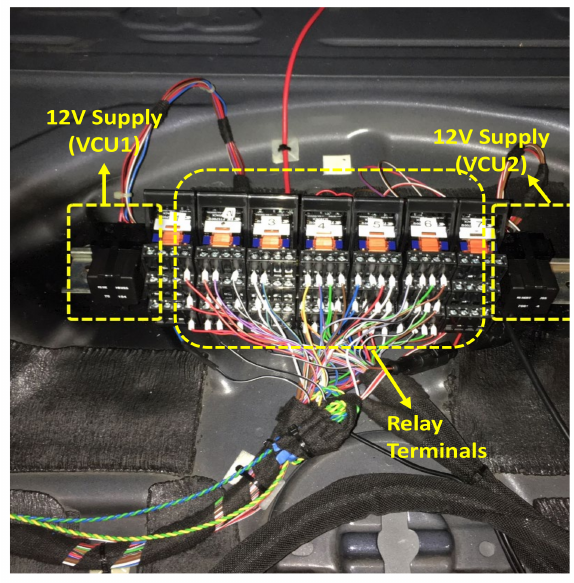
Figure 5. Required relay terminals to activate control of selected VCU.